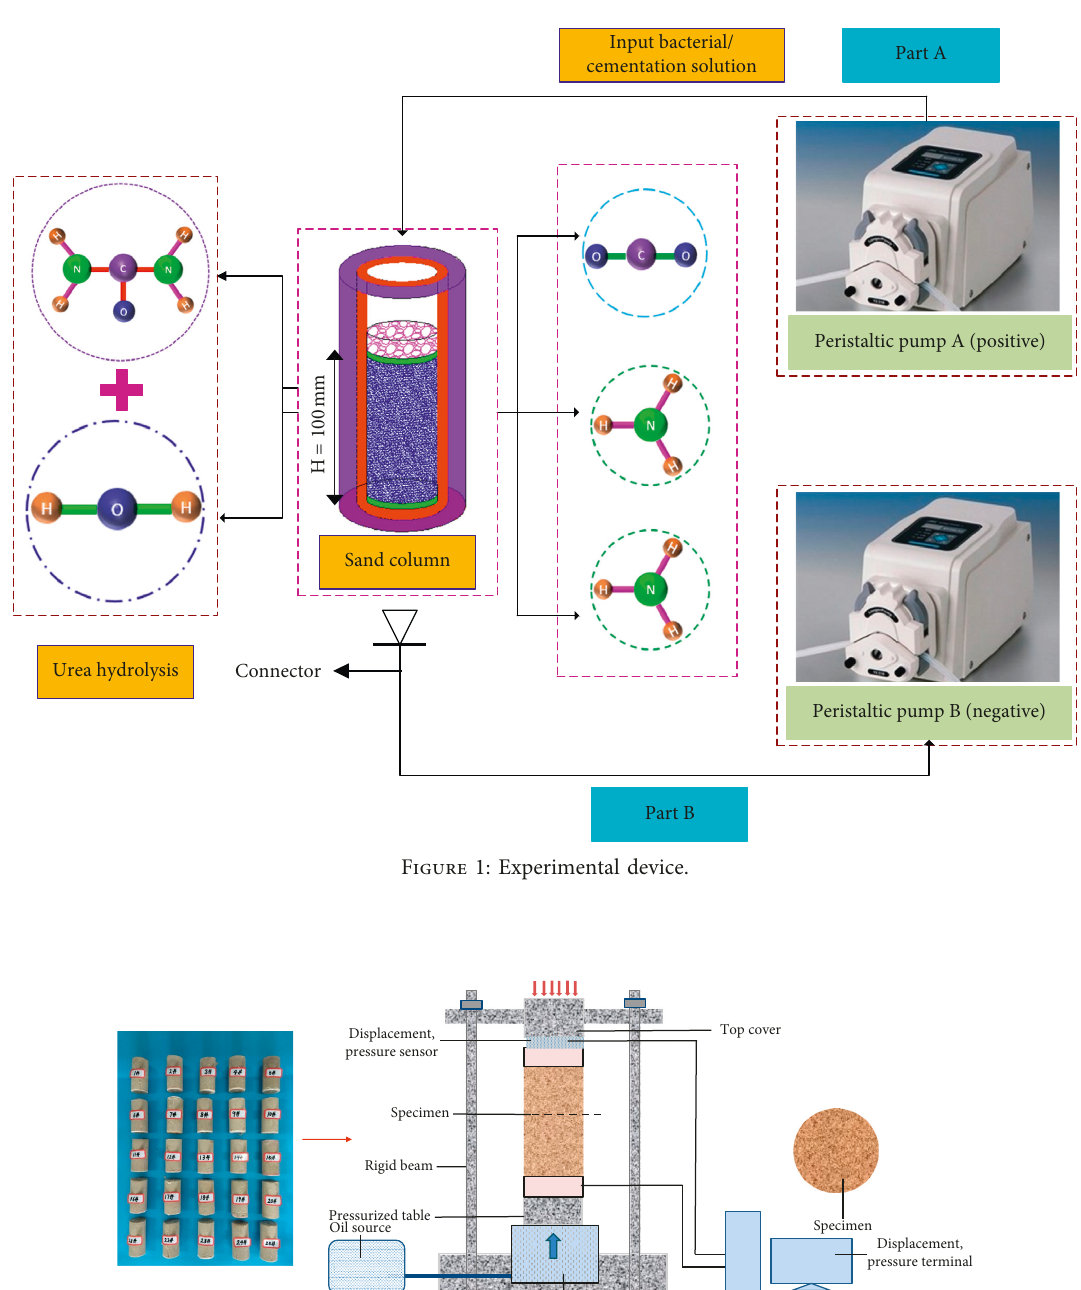
Figure 2: Uniaxial compression